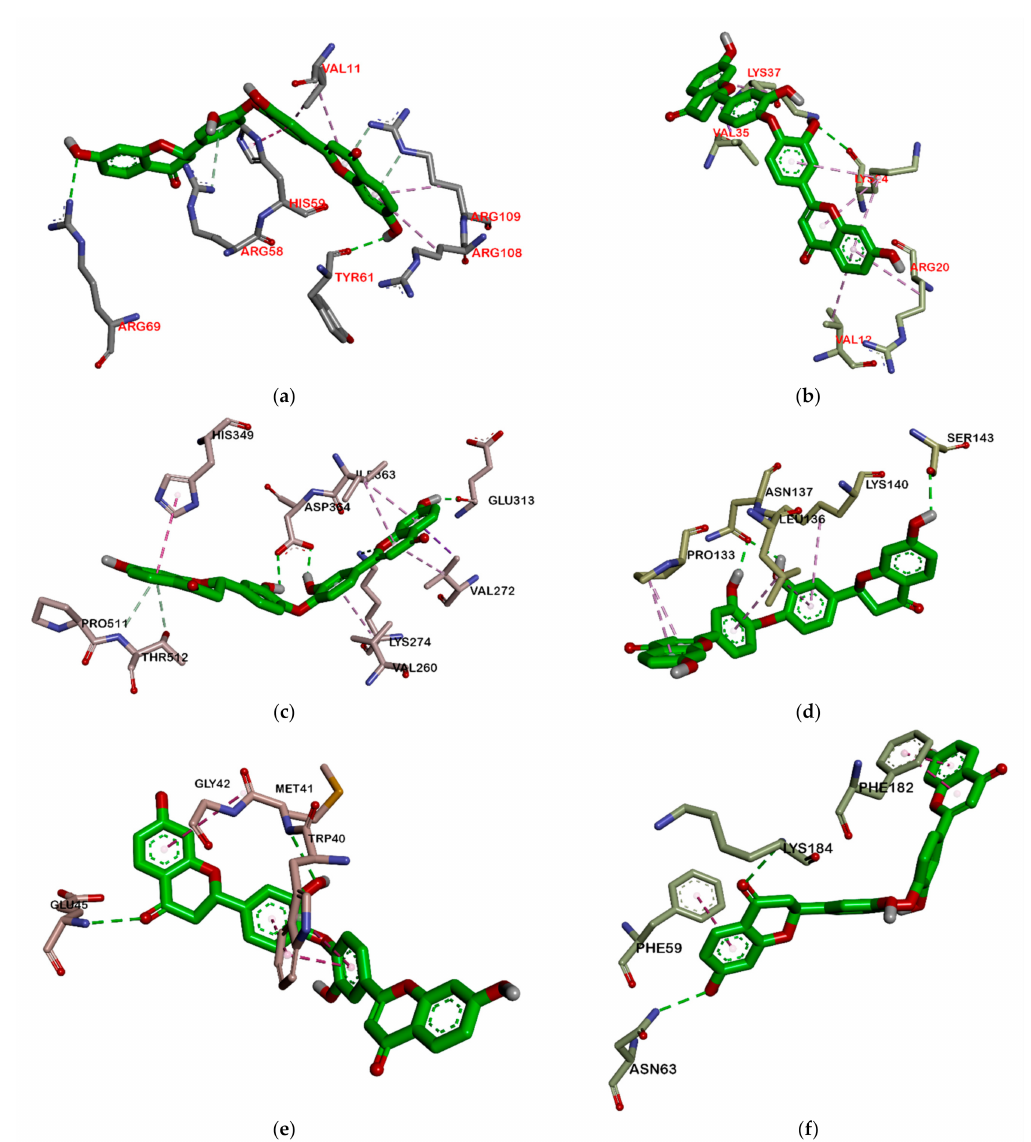
Figure 8. Interaction biflavonoid with protein ribosomal subunit 30S ( a ), ribosomal subunit 50S ( b ), ClyM ( c ), FsrB ( d ), GBAP ( e ), and PgrX ( f